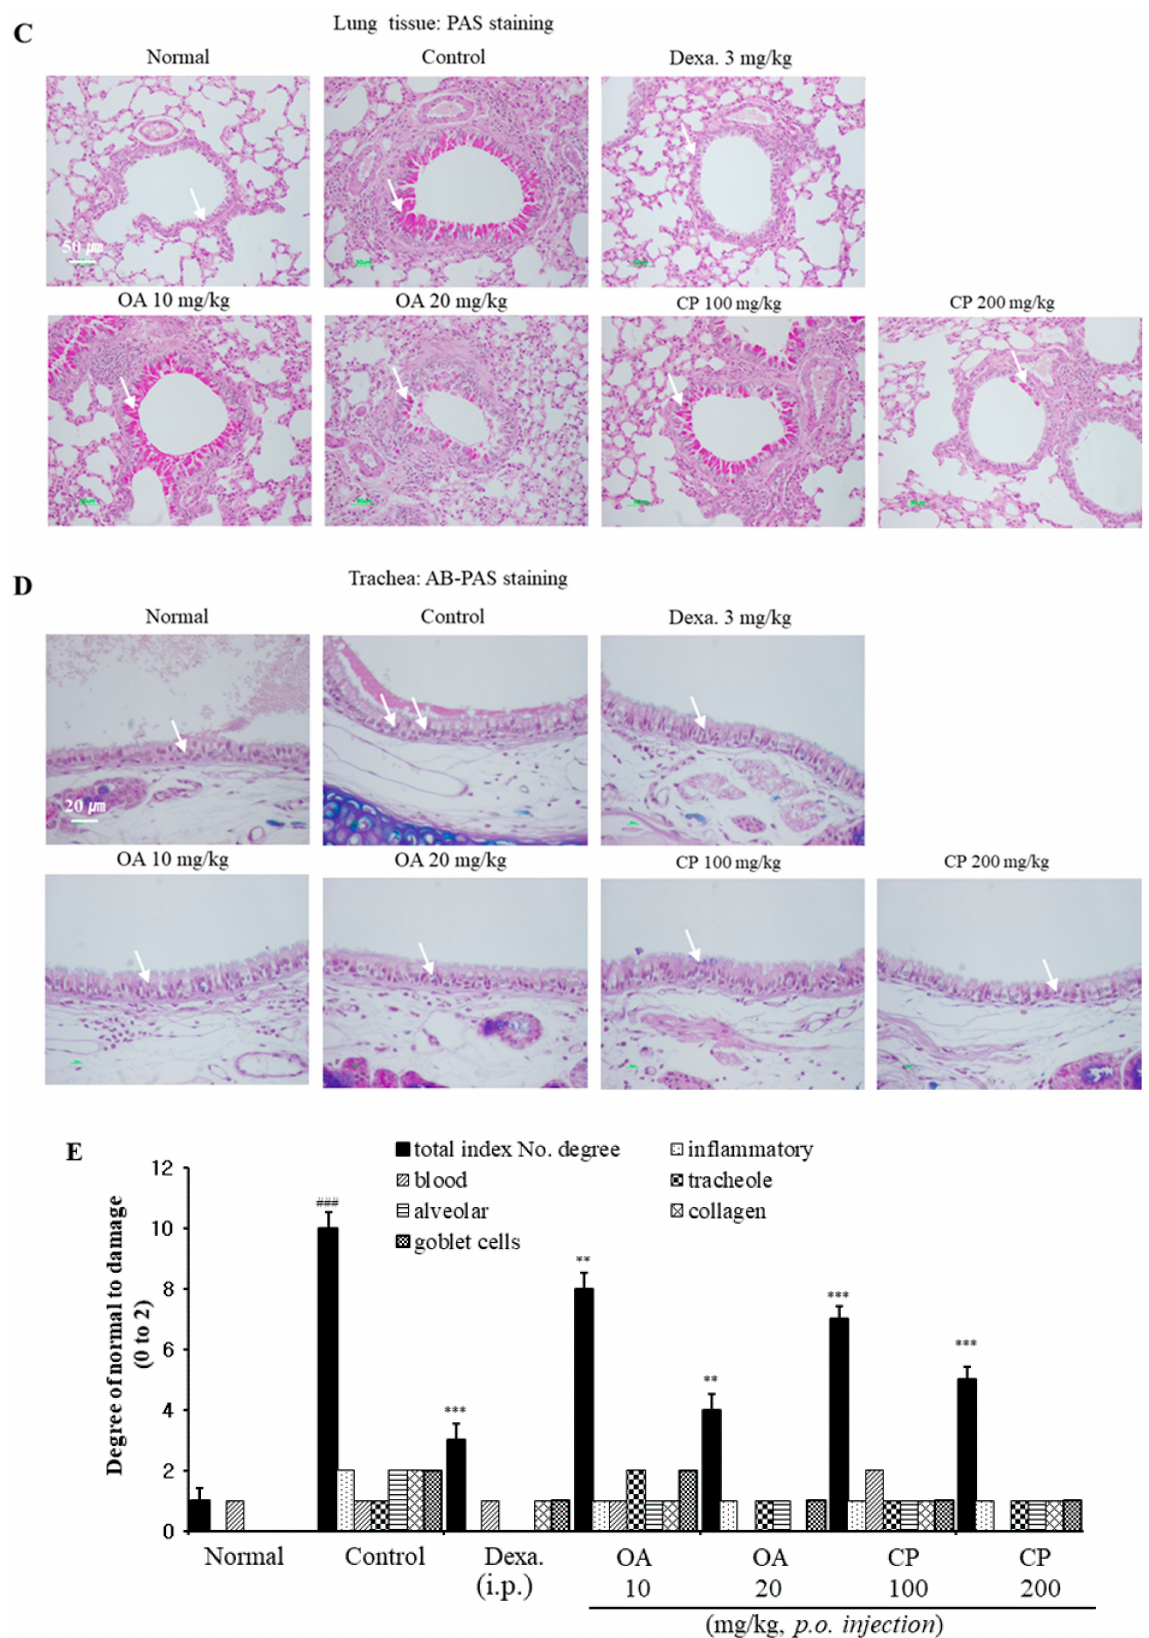
Figure 2. Histological examination of lung tissues. The lung sections were obtained from phosphate-buffered saline